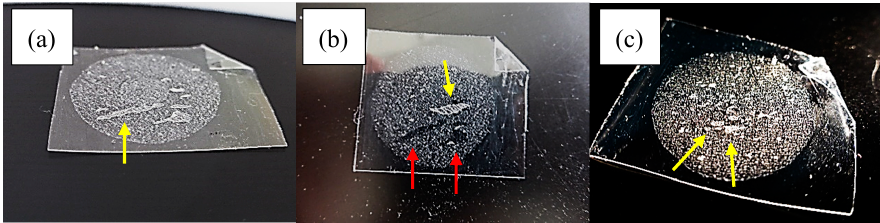
Figure 4. Inhomogeneous tape-stripping observed for subject 5 ( a ) and ( b ) and subject 4 ( c ). Panel ( a ) the yellow arrows indicate areas where clumps of corneocytes were removed by the tape. Panel ( b ) A subsequent tape removed clumps of corneocytes in other sites (yellow arrows) but collected little SC in darker regions (red arrows) that matched the sites where clumping was observed in preceding tapes. Panel ( c ) Example of the inhomogeneous tape stripping observed in another volunteer.